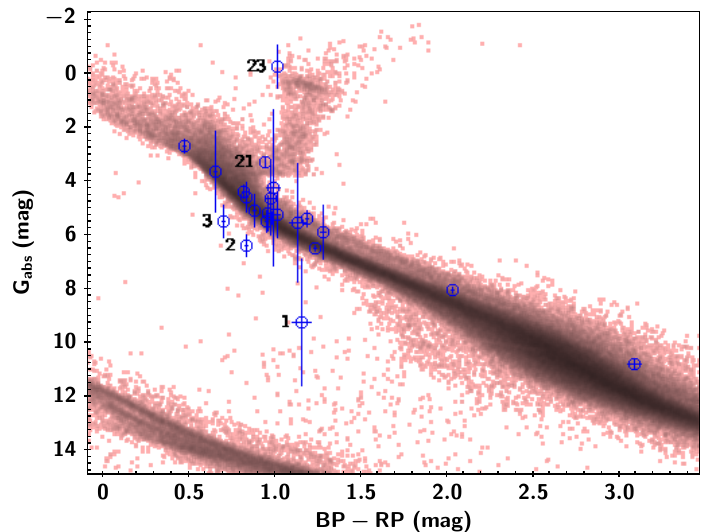
Figure 4. Stars used in Paper18 for the A V ( d ) construction (blue circles) on the HRD. Labels correspond to running numbers of stars in Table 1. Pink points are nearest ( (cid:118) tr > 10 mas) stars from Gaia DR2. Absolute magnitude G abs is calculated from G Gaia and (cid:118) tr , interstellar extinction is neglected. Gaia G, BP and RP curves are presented in Figure